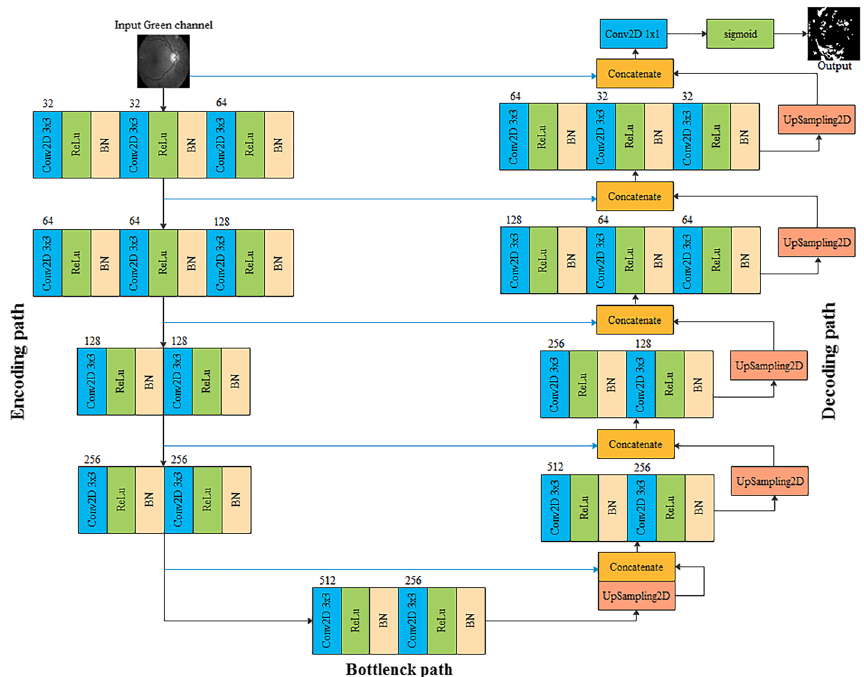
Fig. 7 Modified UNet architecture for hemorrhage segmentation in fundus images for the diagnosis of diabetic